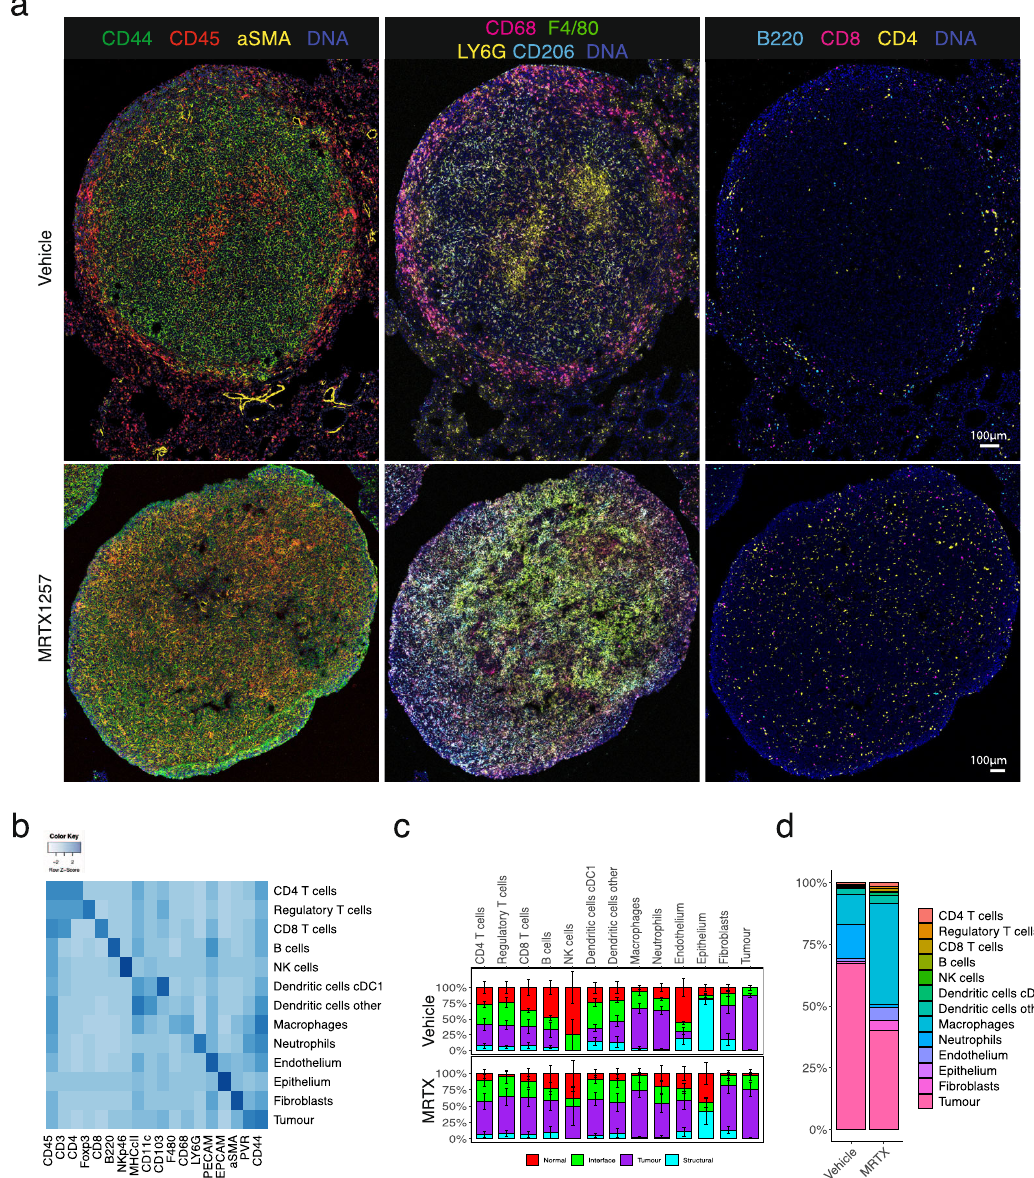
Fig. 3 Characterisation and spatial distribution of cell types in Lewis lung carcinoma model. a Two representative 3LL lung tumours, either treated with vehicle or MTRX1257 for 7 days ( n = 6 for both groups). Overall tissue organisation changes upon KRAS inhibition, with increased CD45 + leucocytes and α SMA + fi broblasts in the tumour domain (left), increased expression of macrophage markers such as F4/80 and CD206 in the tumour (middle), and more T cells in fi ltrating the tumour bed (right). For visualisation purposes, the images were processed in Fiji with a median fi lter (radius 0.5). To enhance visualisation of the small lymphocytes, the channels for CD3, CD4, CD8 and B220 were fi ltered using a band pass Fast Fourier Transformation. b Heatmap showing the expression of 18 lineage markers within the 13 identi fi ed cell types. The heatmap was scaled by row to emphasise the key markers per cluster. c Relative distribution of cell types within the tissue domains, separated by the two treatments. It shows how the fi broblasts, lymphocytes, DCs and macrophages have increased presence in the tumour domain, while neutrophils have been reduced. Error bars indicate the standard error of the mean over the ROIs ( n = 6 for each treatment group). For full statistics using mixed-effects model, see Supplementary Fig. 4. d Proportions of cell types within the tumour domain, separated by treatment. Abbreviations MRTX